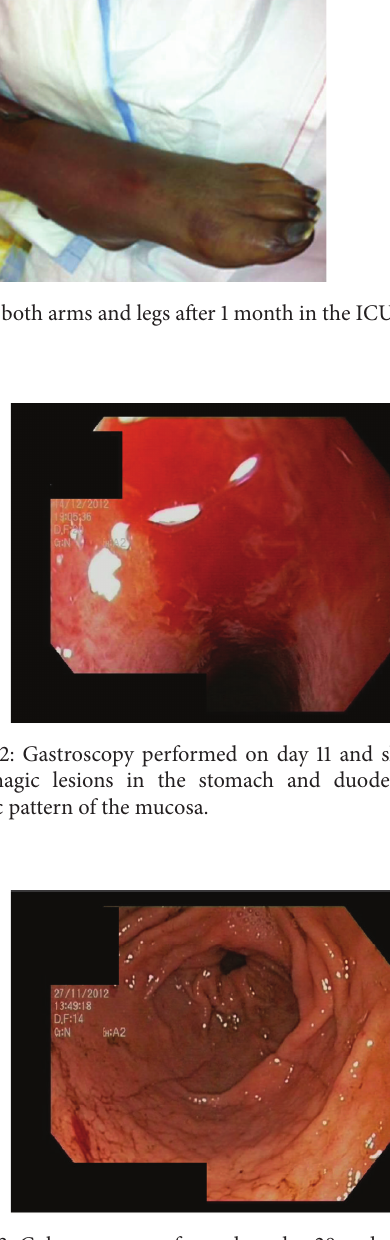
Figure 3: Colonoscopy performed on day 28 and showing diffuse ischemic lesions mainly in the sigmoid